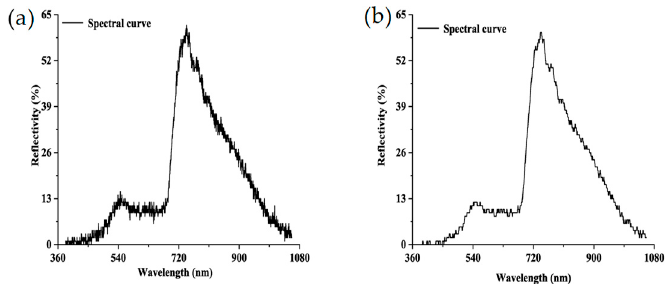
Figure 3. Comparison of hyperspectral reflectance curves between ( a ) original and ( b ) Savitzky–Golay (S-G) filter-smoothed data.